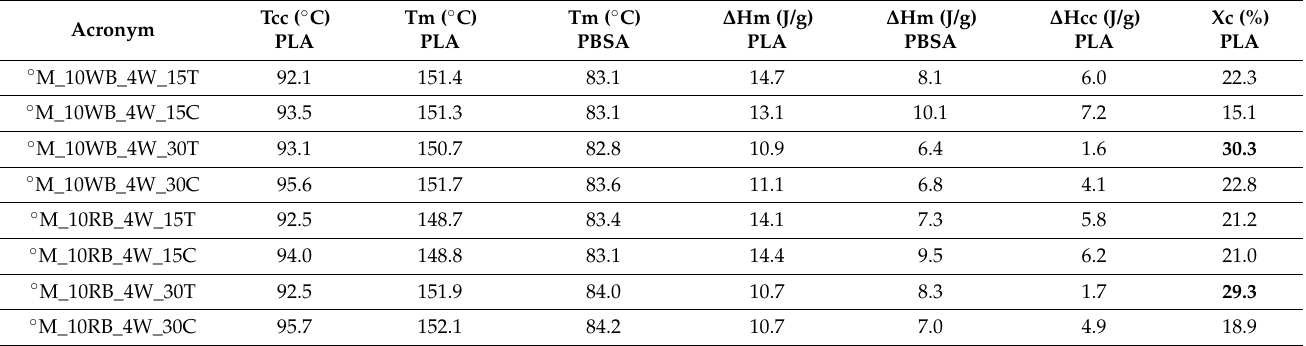
Table 4. Results of differential scanning calorimetry (DSC) analysis (first heating).